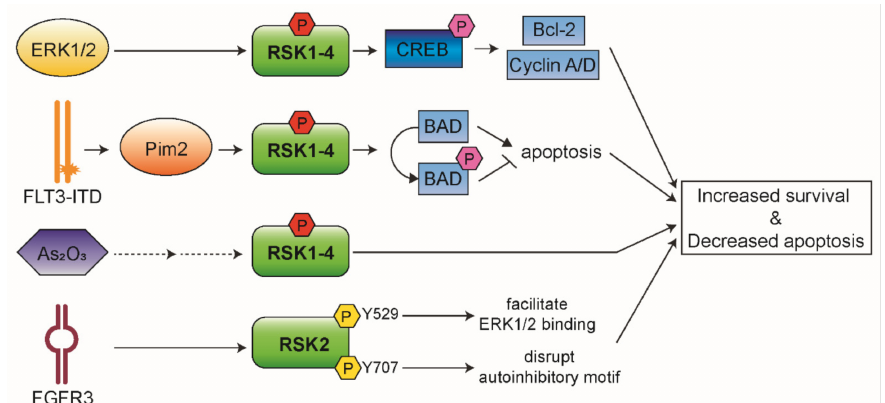
Figure 5. Functional mechanisms of RSK isoforms in AML. RSKs control survival and apoptosis of leukemic cells through aberrantly activated upstream